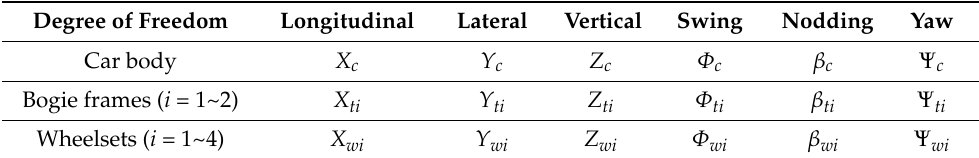
Table 1. Degree of freedom contained in the LIM vehicle system.